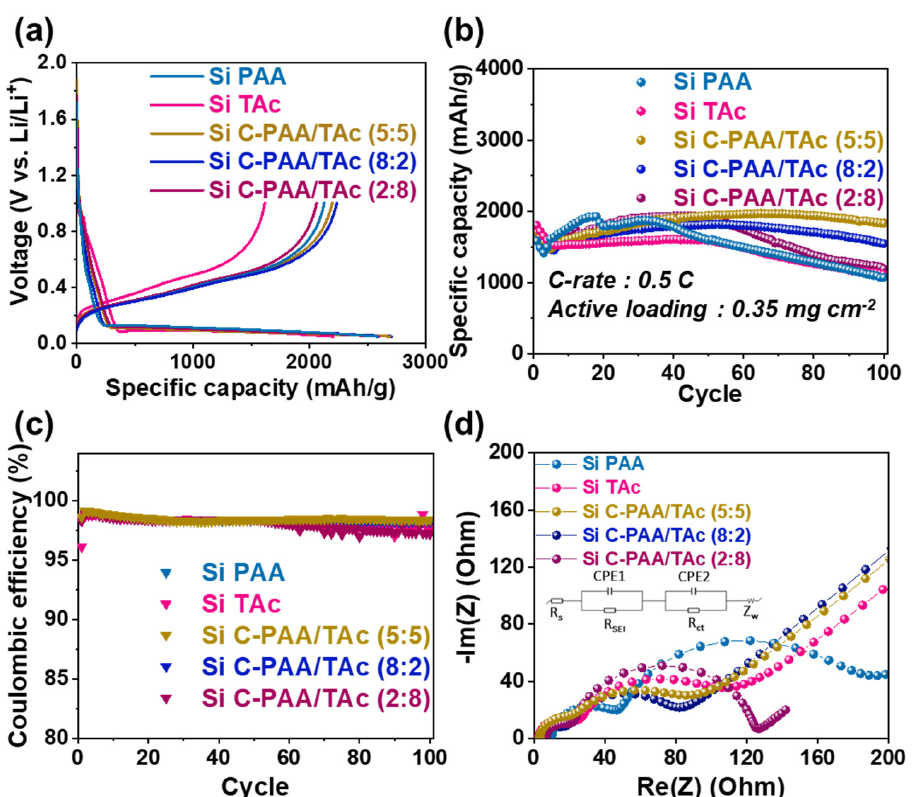
Figure 5. ( a ) Galvanostatic charge/discharge profiles for half cells tested by controlling binder ratio of C-PAA/TAc; ( b ) cycling performance of Si PAA, Si TAc, and Si C-PAA/TAc at 0.5 C-rate; ( c ) Coulombic efficiency of cycling performance of Si PAA Si TAc and Si C-PAA/TAc; ( d ) fitted electrochemical impedance spectroscopy of Si PAA, Si TAc, and C-PAA/TAc after 100